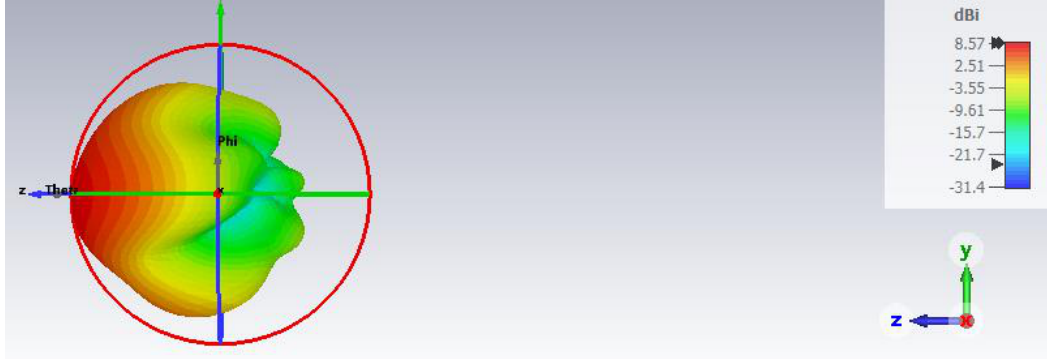
Figure 11. 3D Radiation Pattern